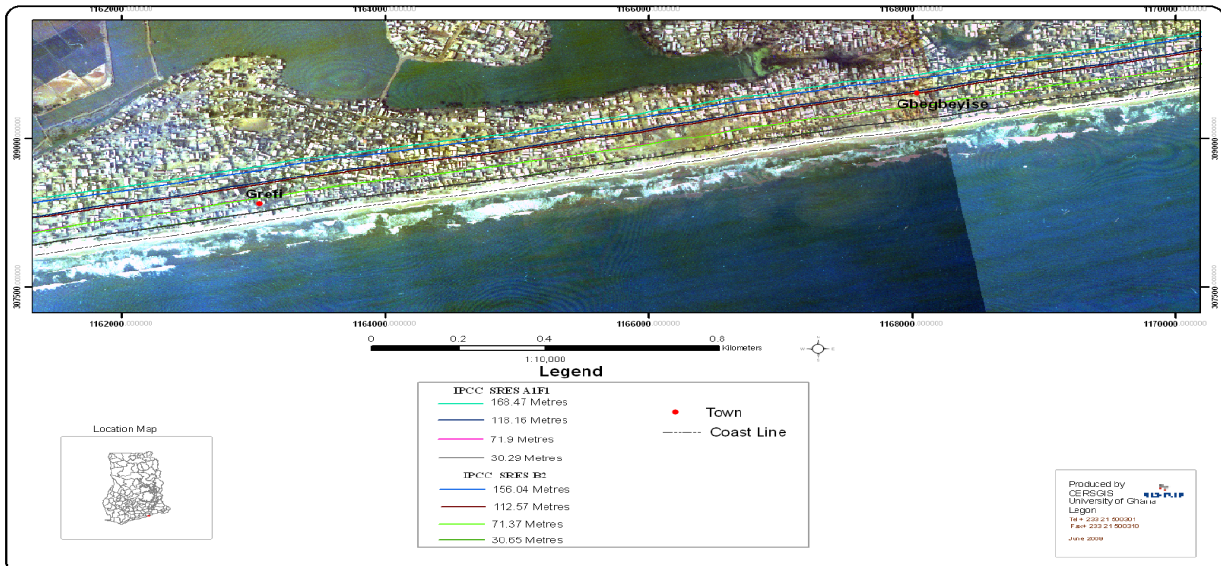
Figure 4. Areas susceptible to permanent inundation in the Grefi and Gbegbeyise